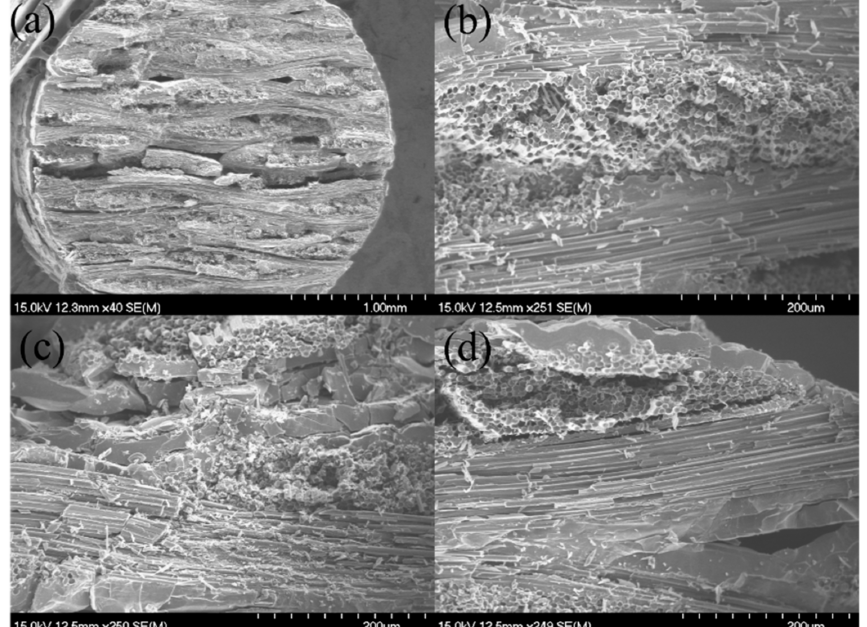
Figure 11. Type I double-shear fracture surface of 2D plain-woven C/SiC pin observed under SEM. ( a ) fracture surface; ( b ) fiber pullout in different plies; ( c ) fiber fracture and pullout; ( d ) fiber fracture and